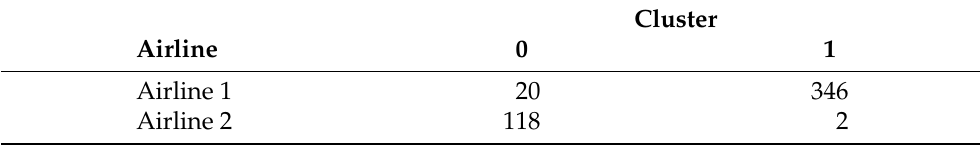
Table 2. Contingency table of airline vs. cluster for the Milan Malpensa and Bari